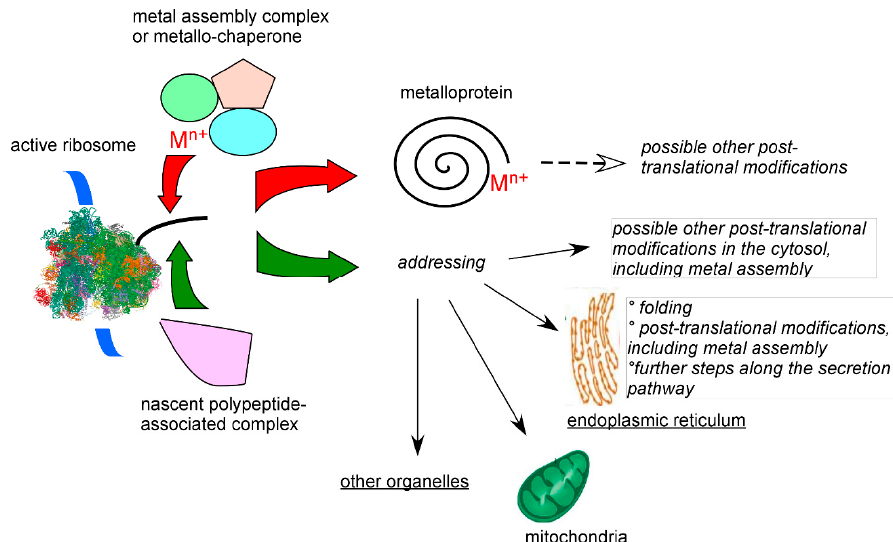
Figure 4. Schematic competition between metal insertion and other post-translational modifications on newly synthesized proteins bearing metal ligands. On the left, the blue ribbon represents the translated mRNA and the black tube the produced protein on active ribosomes. Cytosolic metal insertion depends not only on the recipient protein but also on the cellular environment. What commits the newly synthesized polypeptide either to (top, red arrow) swift metal insertion, or (bottom, green arrow) to further cytosolic processing or translocation to organelles in eukaryotes with delayed metal assembly is unknown. Metals insertion may indeed occur in organelles as better known in mitochondria for iron-sulfur or hemoproteins .